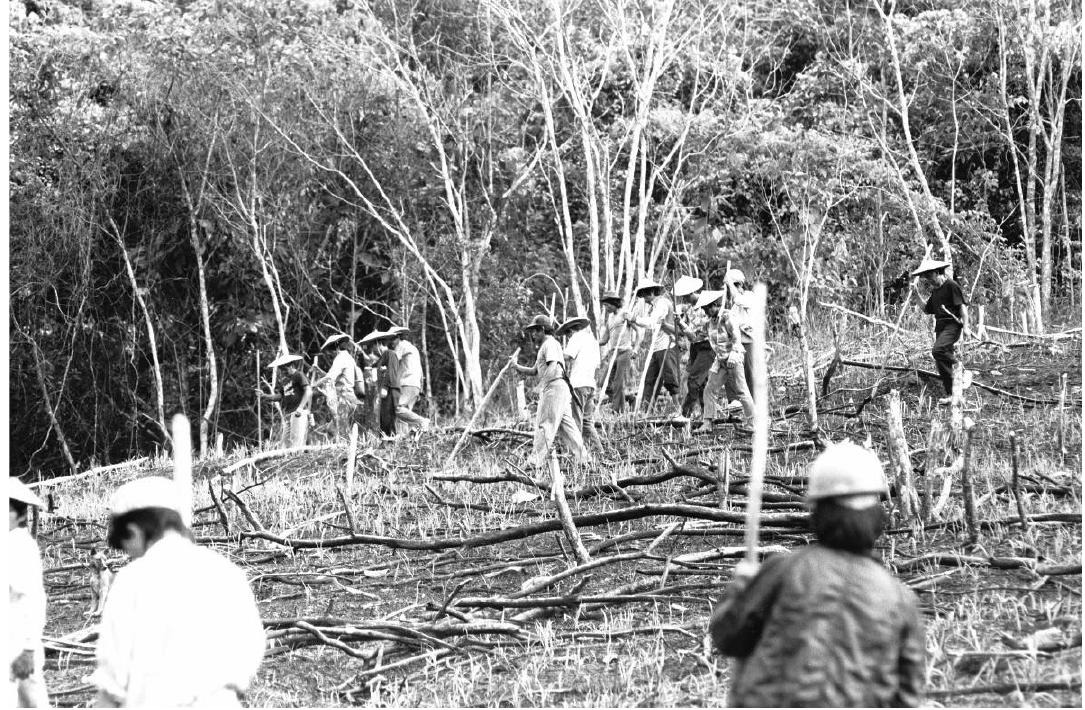
Figure 3. Swidden farmers prepare a recently burned field cleared from secondary forest for planting with hill rice seed